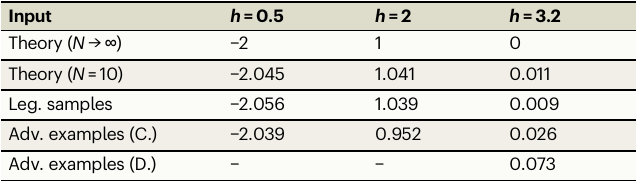
Table 2 | The Hopf index calculated by using the conventional discretization approach